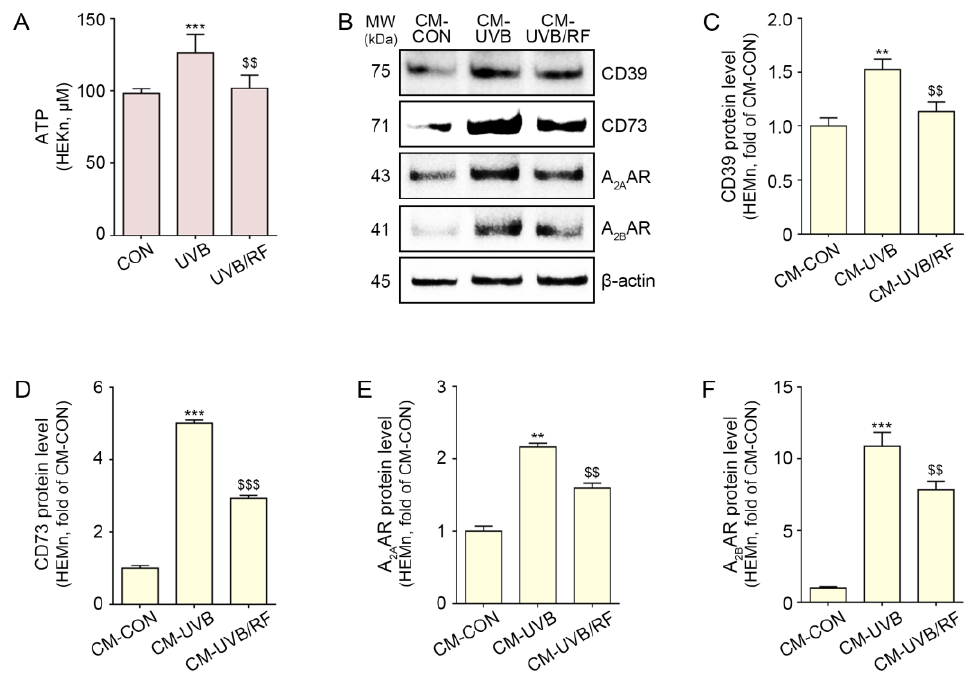
Figure 1. CD39/CD73/A 2A AR/A 2B AR reduction in melanocytes through regulation of ATP release from UVB/RF-exposed keratinocytes. HEKn were not exposed or exposed to UVB for 5 min (CON or UVB group), and then RF was irradiated after exposure to UVB (UVB/RF group). ( A ) ATP release in the CON group, UVB group, and UVB/RF group was verified using an ATP release assay. ( B – F ) HEMn were treated with a supernatant of HEKn (CM-CON), UVB-exposed HEKn (CM-UVB), or UVB and RF-treated HEKn (CM-UVB/RF) for 48 h. ( B ) The protein expression of CD39/CD73/A 2A AR/A 2B AR in CM-treated HEMn was measured by Western blot. ( C – F ) Quantitative